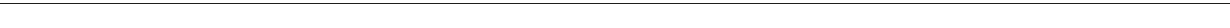
Fig. 1 Correlation between Ash1L expression and myoblast fusion. a Ash1L expression during muscle development. RT-qPCR analysis on muscle tissue from hindlimbs of mice from the embryonic stage E16.5 to adulthood (p28). Expression analysis of Myomaker , as a positive fusion gene, and adult myosin ( Myh4 ) as a positive control for adult stages. Unpaired two-tailed t test. Con fi dence intervals 95%. n = 6. b Ash1L expression in regenerating muscle tissue. RT-qPCR analysis of Ash1L expression in tibialis anterior of wild-type adult mice, untreated (UNT), or 5 and 10 days after cardiotoxin (CTX) injection (left panel). Immuno fl uorescence for Ash1L (in green) and nuclear staining (Hoechst), in transverse cryosections from the tibialis anterior muscles of injured wild-type mice, 5 days after cardiotoxin injection (CTX 5 days) compared to untreated controls (Unt). Scale bar, 50 μ m. Magni fi cation ×65. Arrows indicate the Ash1L-positive nuclei. Unpaired two-tailed t test. Con fi dence intervals 95%. n = 4. c Ash1L protein level during in vitro muscle differentiation. Immunoblot of C2C12 cells at days 0 and 1, and densitometric analysis of Ash1L signal relative to vinculin as housekeeping protein (left panel). Immuno fl uorescence for Ash1L (in green) and nuclear staining (Hoechst), in C2C12 cells at days 0 and 1 of in vitro muscle differentiation. Scale bar, 100 μ m. Magni fi cation ×20. Paired two-tailed t test. Con fi dence intervals 95%. Data are the mean for three independent experiments. d Ash1L protein level in proliferating myoblasts vs. con fl uent cells. Comparison between proliferating myoblasts (P) and con fl uent cells (C). Paired two-tailed t test. Con fi dence intervals 95%. Data are the mean for three independent experiments. Source data are provided as a Source Data fi le. * p ≤ 0.05, ** p ≤ 0.01, *** p ≤ 0.001, **** p ≤ 0.0001. NS not signi fi